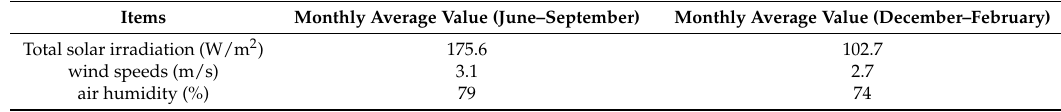
Table 1. Meteorological parameters for Shanghai region.